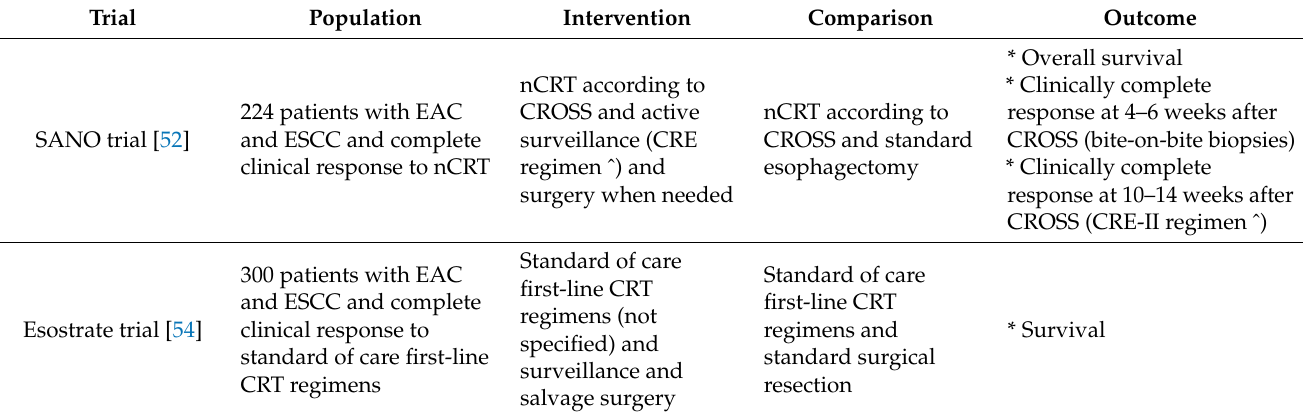
Table 4. Summary of study design from prospective studies discussed in Section